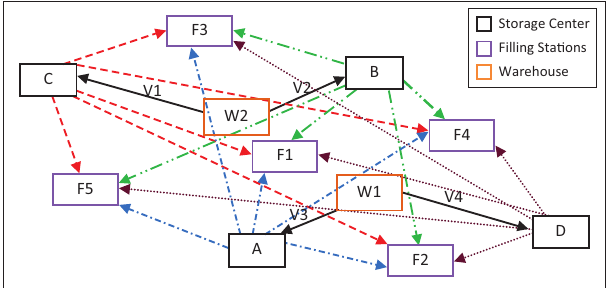
FIGURE 2: Oil marketing companies accessing and distributing refined petroleum products.